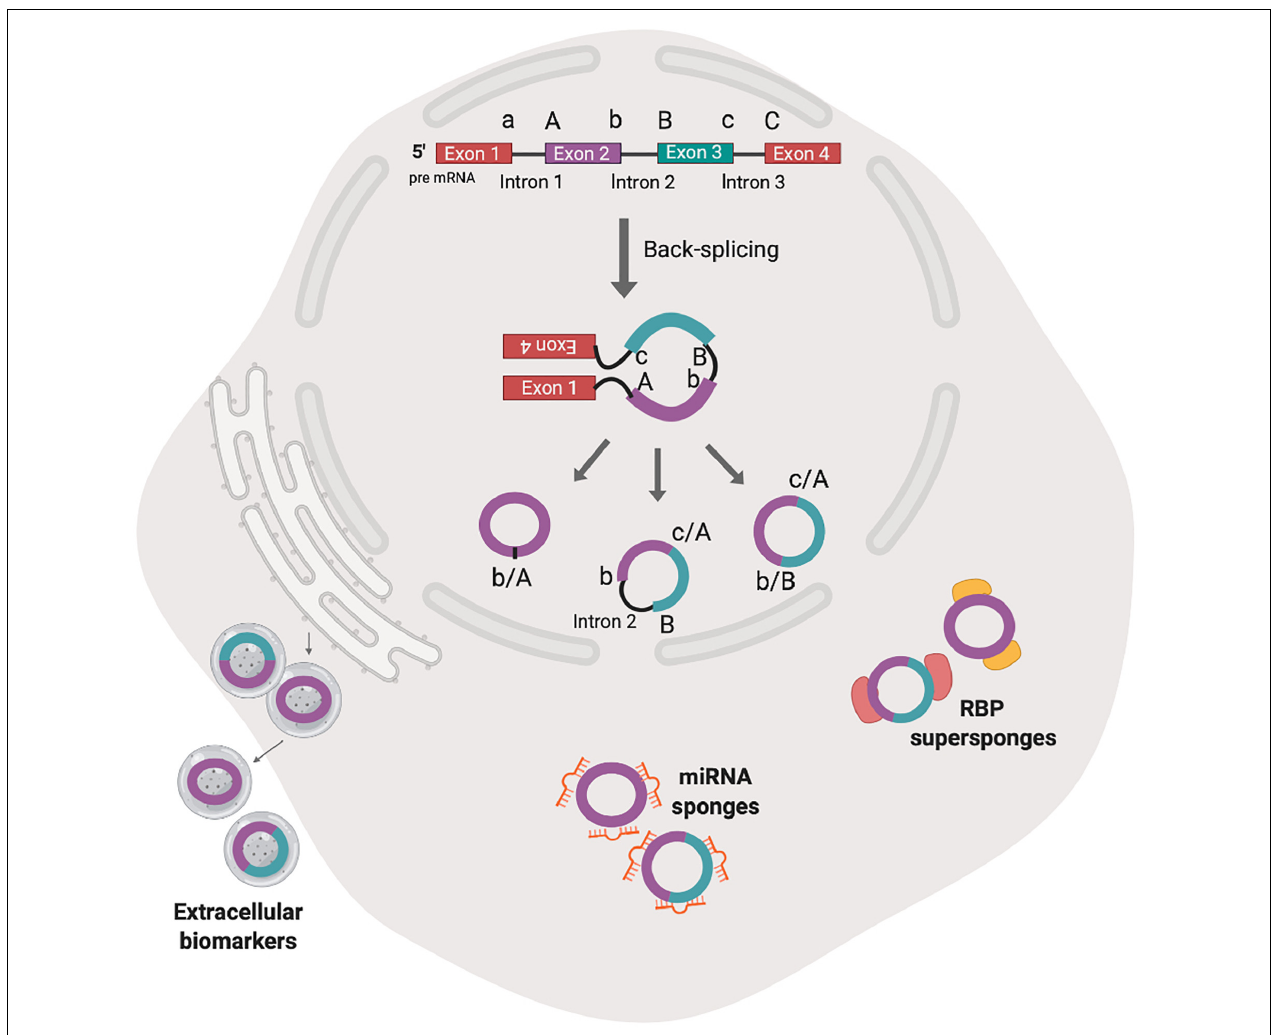
FIGURE 2 | The biogenesis by non-canonical splicing and activities of animal circRNAs. Back-splicing model shown here is hypothesized to be the predominant mechanism of animal circRNA biogenesis. The non-linear combination of 3 (cid:48) splice donor (a, b) and proximal 5 (cid:48) splice acceptor (A, B) generates single exon circRNA (b/A), backspliced exons (c/A, b/B) or exons and introns (c/A, b intron 2 B). After nuclear export, the circRNA have been shown to accumulate in exosomes and may serve as extracellular biomarkers. Cytosolic circRNAs have been shown to interact with cognate microRNA (miR) and RNA binding proteins (RBPs) (sponge) in competition with miR response element on target mRNAs or another protein